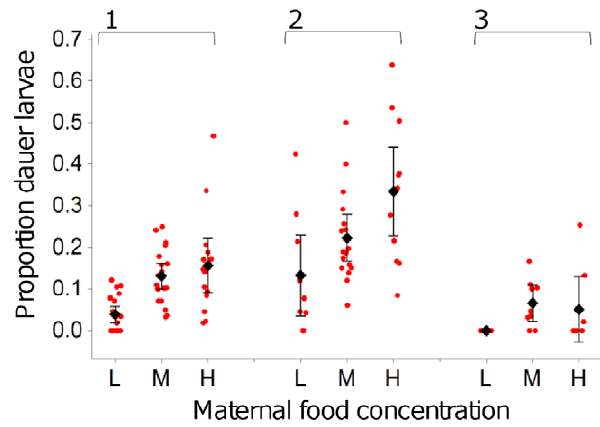
Figure 3. Maternal food availability affects development fate. Jitter plot showing the proportions of the L1 progeny of mothers from high (H), medium (M) and low (L) maternal food concentrations that developed as dauer larvae in three independent experiments (1–3). The mean proportion ( 6 95% confidence interval) of L1 progeny that developed as dauer larvae is also shown for each treatment. In all cases High maternal food availability was 10% w/v E. coli . Medium maternal food availability was 2.5% w/v E. coli for assays 1 and 3, and a combination of 2.5% and 5% w/v E. coli treatments for assay 2. Low maternal food availability was 1.25% w/v E. coli for assays 2 and 3, and a combination of 1.25% and 0.625% w/v E. coli treatments for assay 2. Mean proportions were calculated from 8–20 plates/treatment (median 12).